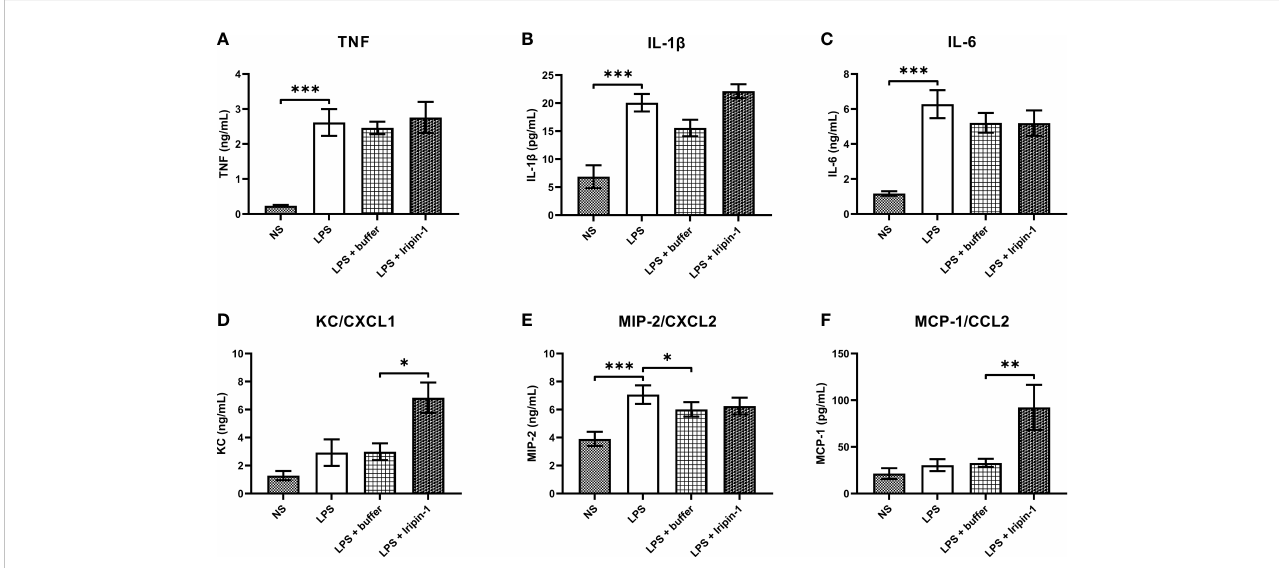
FIGURE 5 Iripin-1 potentiates the secretion of chemokines for neutrophils (KC) and monocytes (MCP-1). Resident peritoneal cells were treated with 2 m M Iripin-1 or the corresponding amount of control buffer and then were stimulated by LPS (1 m g/mL). Cell-free supernatants, collected 4 h after LPS addition, were utilized for the measurement of concentrations of pro-in fl ammatory cytokines TNF (A) , IL-1 b (B) , and IL-6 (C) and chemokines KC (D) , MIP-2 (E) , and MCP-1 (F) . Data are expressed as mean values ± SEM, and statistically signi fi cant differences between the groups NS and LPS, LPS and LPS + buffer, LPS + buffer and LPS + Iripin-1 are marked with asterisks (*p < 0.05, **p < 0.01, ***p < 0.001). The experiment was repeated four times. NS, unstimulated